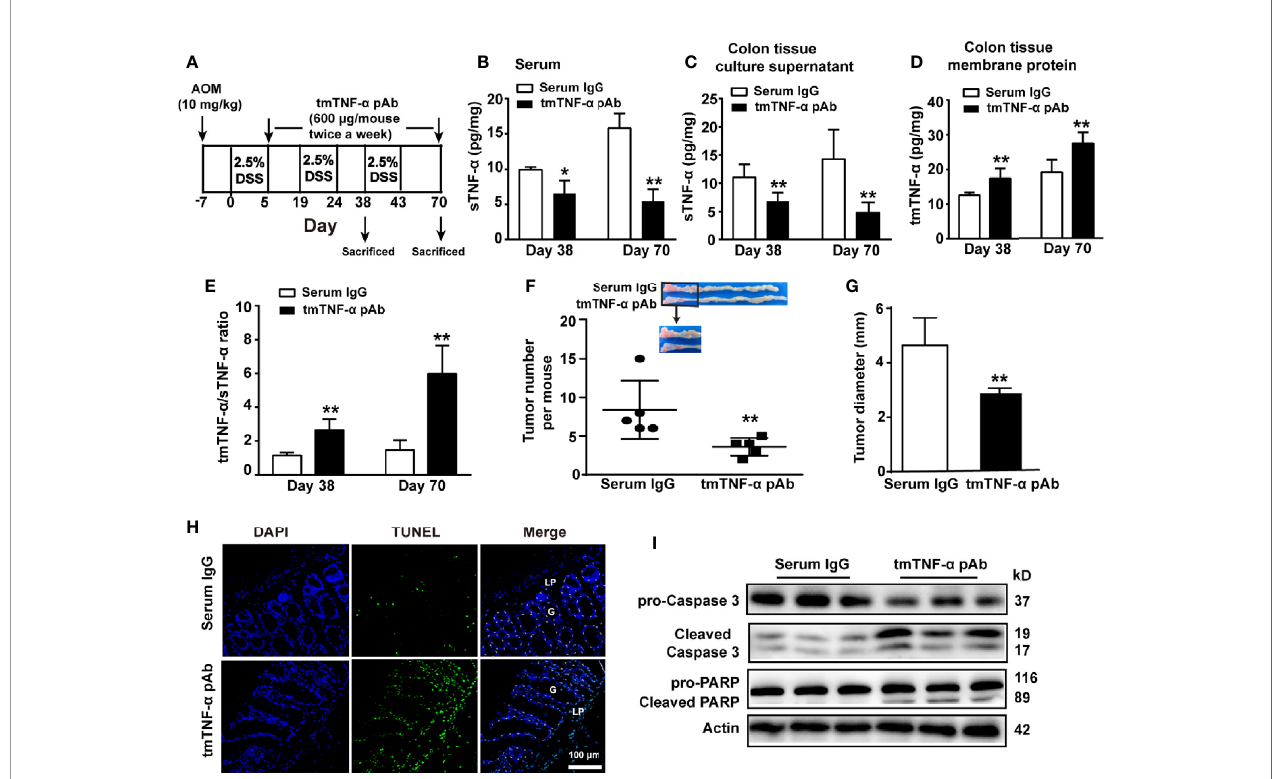
FIGURE 5 | tmTNF- a antibody treatment in the fi rst in fl ammation stage suppresses tmTNF- a shedding and tumor growth. (A) Schematic treatment of mice with tmTNF- a polyclonal antibody (pAb) in AOM/DSS-induced CAC. Mice were intraperitoneally injected with 600 m g of tmTNF- a pAb twice a week, and the treatment was from day 5 to day 70. Normal rabbit serum IgG served as a control. (n = 5, each group) (B) Serum concentrations of sTNF- a detected by ELISA. Levels of sTNF- a released in supernatants (C) and tmTNF- a expression in the membrane protein (D) of 24-h-cultured colonic tissues detected by ELISA and their ratios (E) on day 38 and day 70. (F, G) Tumor number and size. (H, I) Representative images of apoptosis in diseased colons detected by TUNEL (×200), and western blot analysis for cleavage of caspase 3 and PARP on day 70. G: glands; LP: lamina propria. All quantitative data represent the mean ± SEM. *P < 0.05, **P < 0.01 versus serum